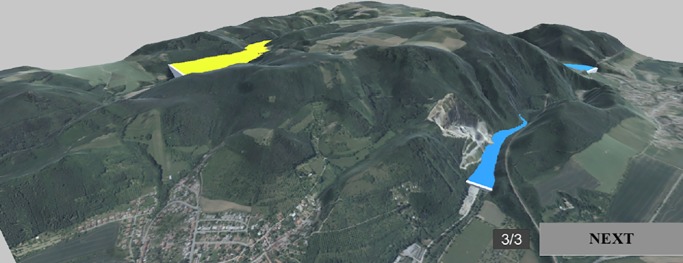
Example of Task 2 –Water bodies in the terrain.Yellow indicates that this object was selected by the participant. Adapted from [61] under a CC BY license, with permission from [ČÚZK], original copyright [2018/2019].